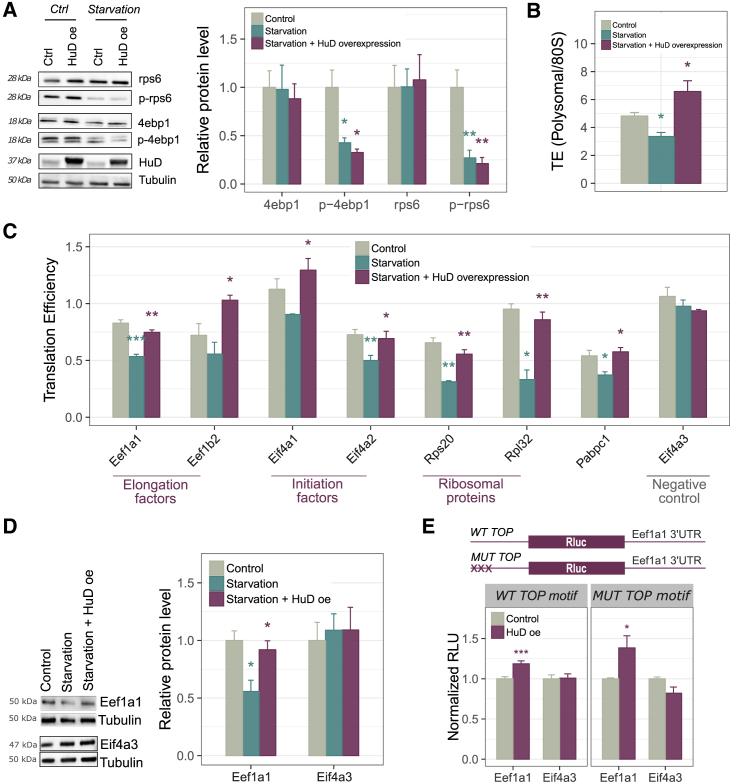
HuD Enhancement of Global and Target-Specific Translation Efficiency Does Not Depend on the mTORC1 Pathway(A) Left: western blot analysis of Rps6 and Eif4ebp1 phosphorylation following serum deprivation (8 hr) in NSC-34 cells.(B) Measurement of global TE by sucrose gradient centrifugation in the following conditions: control, starvation, and starvation coupled with HuD overexpression.(C) TE quantification of selected mTOR-responsive mRNAs in control, starvation, and starvation coupled with HuD overexpression conditions. Target-specific TE is the ratio between polysomal and total RNA changes measured by RT-qPCR. Gapdh and Als2 were used as reference genes.(D) Western blot analysis of Eef1a1 and Eif4a3 in NSC-34 cells collected in three different conditions: control, starvation, and starvation with HuD overexpression.(E) Barplot displaying normalized luciferase intensity values in HEK293 cells transiently transfected with HuD, relative to transient transfection of the empty vector. Cells were co-transfected with wild-type (WT) or mutated (MUT) TOP motif bearing luciferase vectors with the 3′UTR of Eef1a1 (HuD target) or Eif4a3 (negative control).In (A)–(E), data are represented as mean ± SEM t test ∗p < 0.05, ∗∗p < 0.01, and ∗∗∗p < 0.001. In (A)–(C), “Starvation” was compared to “Control,” and “Starvation + HuD overexpression” was compared to “Starvation” for testing statistical significance.See also Figure S3.